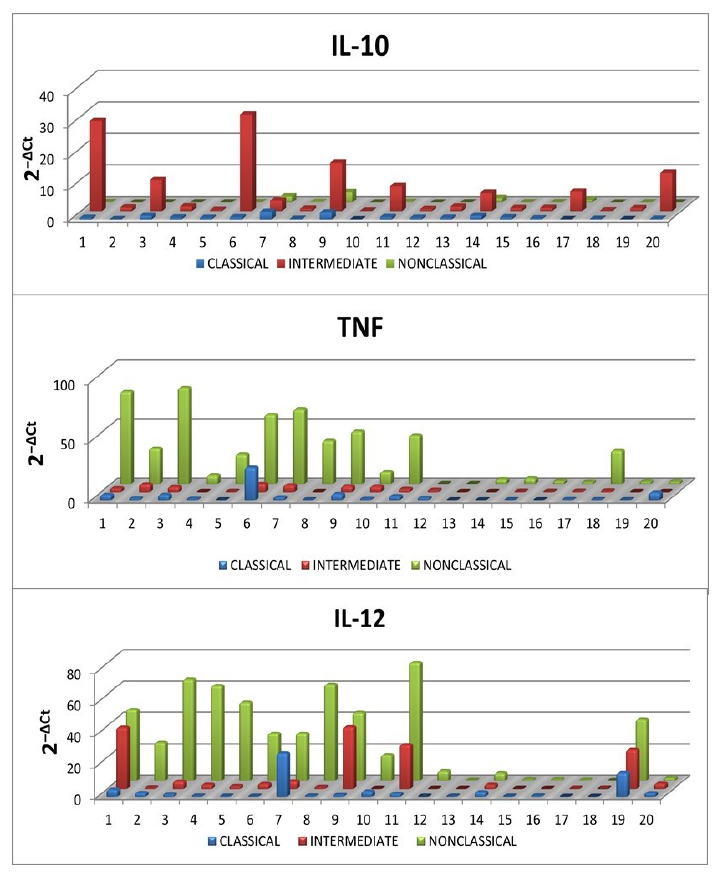
Figure 9. Expression of IL-10, TNF and IL-12 at the mRNA level in classical (CD14 + CD16 − SLAN − ), intermediate (CD14 + CD16 + SLAN − ) and non-classical monocytes (CD14 dim CD16 + SLAN + ) in ex vivo conditions in 20 randomly selected CLL patients.